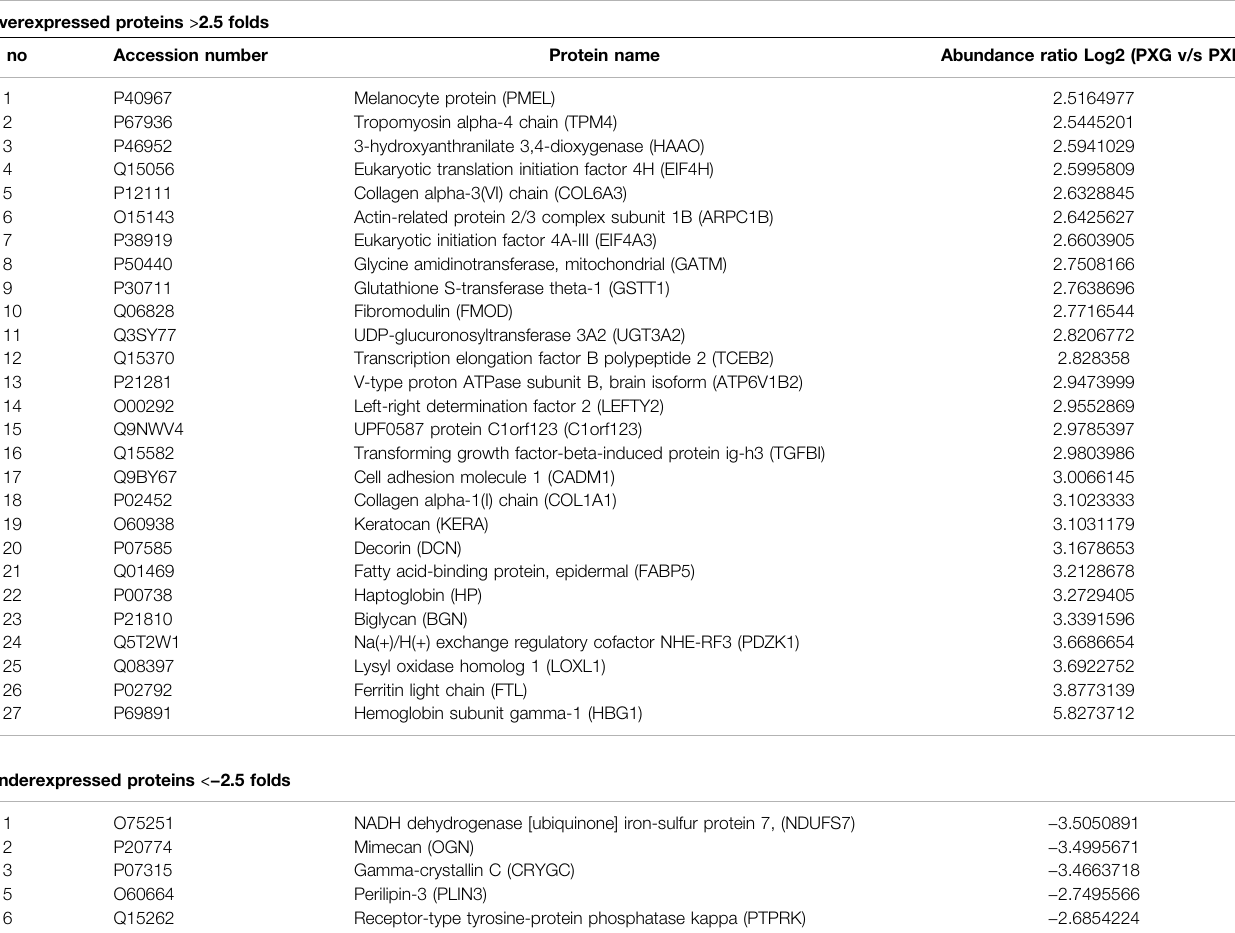
TABLE 3 | Top overexpressed and underexpressed proteins in the lens capsules with pseudoexfoliation glaucoma (PXG) compared to pseudoexfoliation (PXF) syndrome. Overexpressed proteins > 2.5